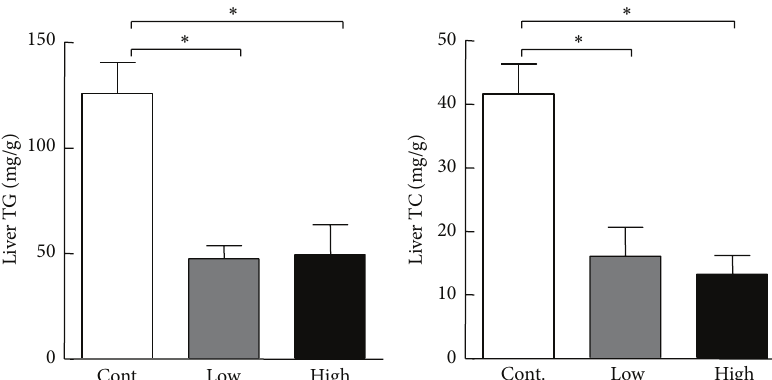
Figure 8: Liver total cholesterol (TC) and triglycerides (TG). Data were analyzed with ANOVA. Data are expressed as the mean ± SEM. 𝑛 = 8 for each group. ∗ 𝑃 < 0.05 versus